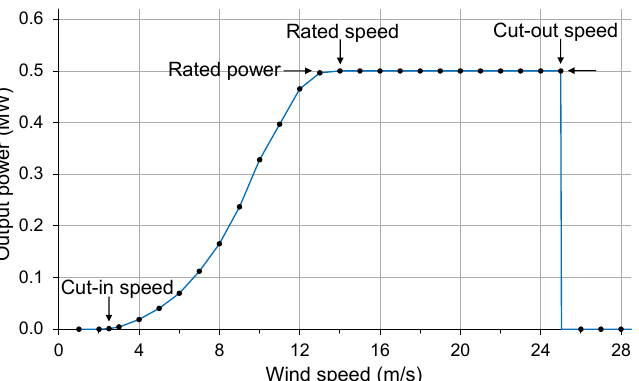
Figure 2. Typical power curve (blue line) of a wind turbine using the example of an Enercon E-40 with 0.5 MW rated power. The black dots on the power curve mark the discrete values as given in the manufacturer’s datasheet [16]. The depicted characteristic parameters of the power curve are explained in the following text.